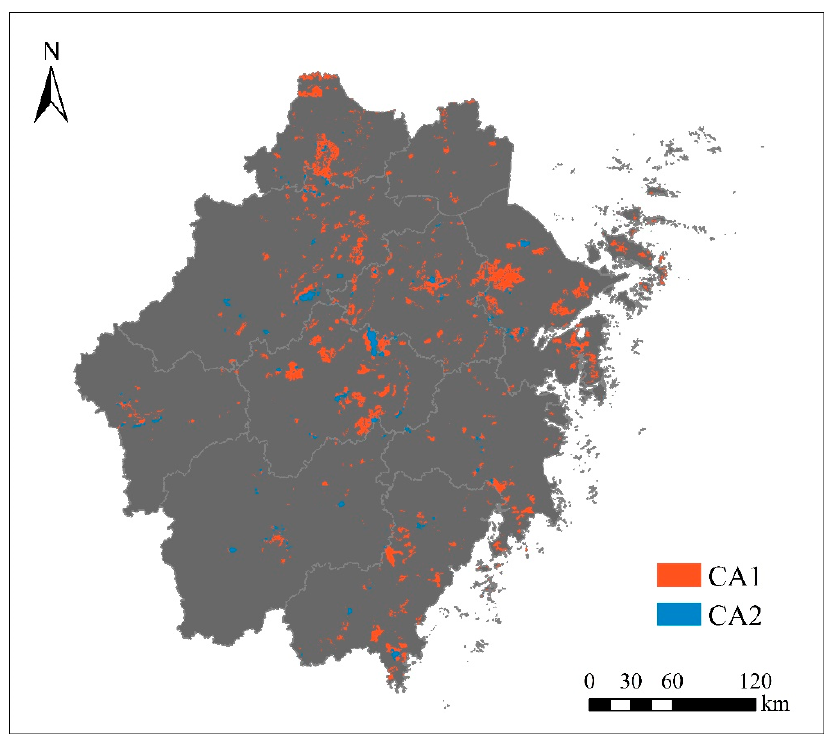
Figure 9. Delineation results of crucial areas of the study area in 2019.